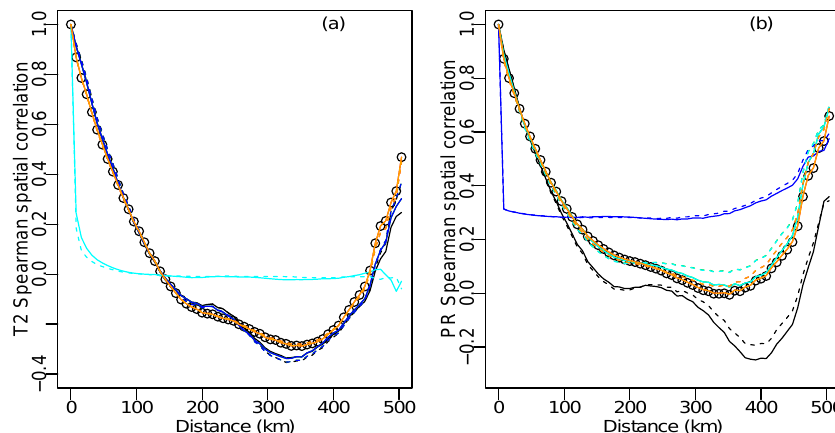
Figure 10. Spatial correlograms of temperature (a) and precipitation (b) in winter computed from daily areal mean-removed data. Correla- tions from SAFRAN are in circles; those from the WRF RCM are in black lines; 1d-BC in green; 2d-R 2 D 2 driven by temperature in blue; 2d-R 2 D 2 driven by precipitation in cyan; 3012d-R 2 D 2 driven by temperature at a given location in red; 3012d-R 2 D 2 driven by precipitation at the same location in orange. Solid lines indicate results for the historical period and dashed lines for the 2071–2100 period. Note that for temperature results (a) , green and blue lines are superimposed. For precipitation (b) , green and cyan are superimposed. Red and orange lines are always superimposed for both (a) and (b)